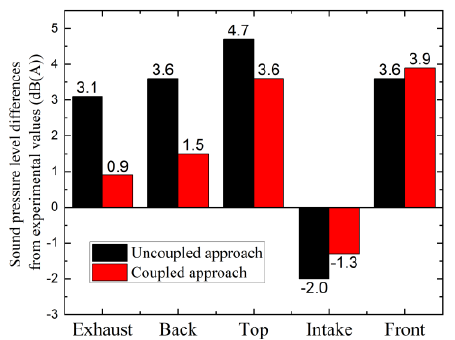
Figure 31. The sound pressure level differences of the two simulation approaches from the experimental values.